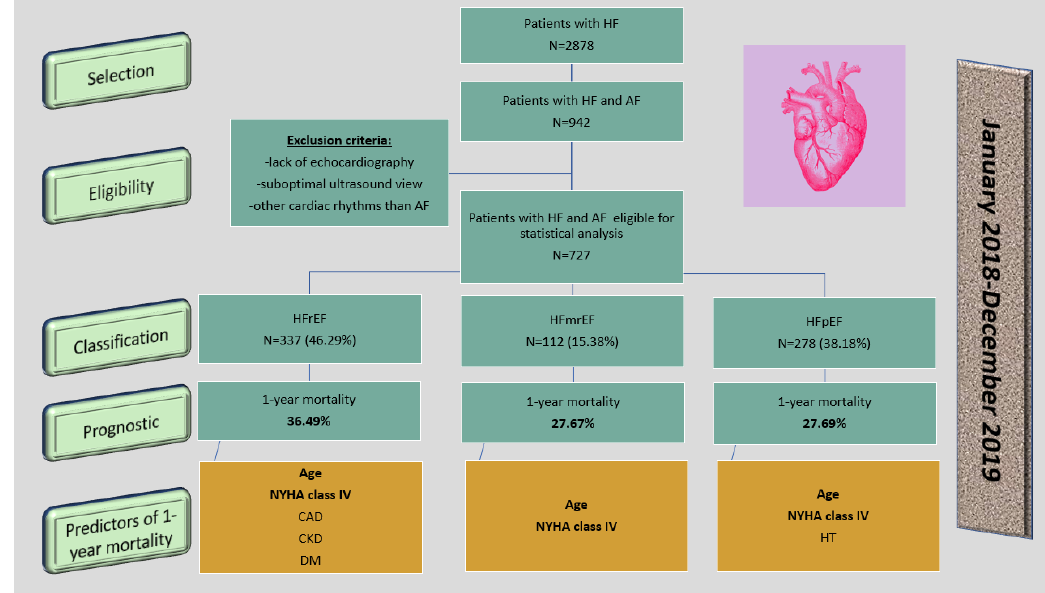
Figure 1. The protocol of the study. Legend: HF—heart failure; AF—atrial fibrillation; HFrEF—heart failure with reduced ejection fraction; HFmrEF—heart failure with mid-range ejection fraction; HFpEF—heart failure with preserved ejection fraction; NYHA—New York Heart Association; CAD—coronary artery disease; CKD—chronic kidney disease; DM—diabetes mellitus; HT—hyper- tension.